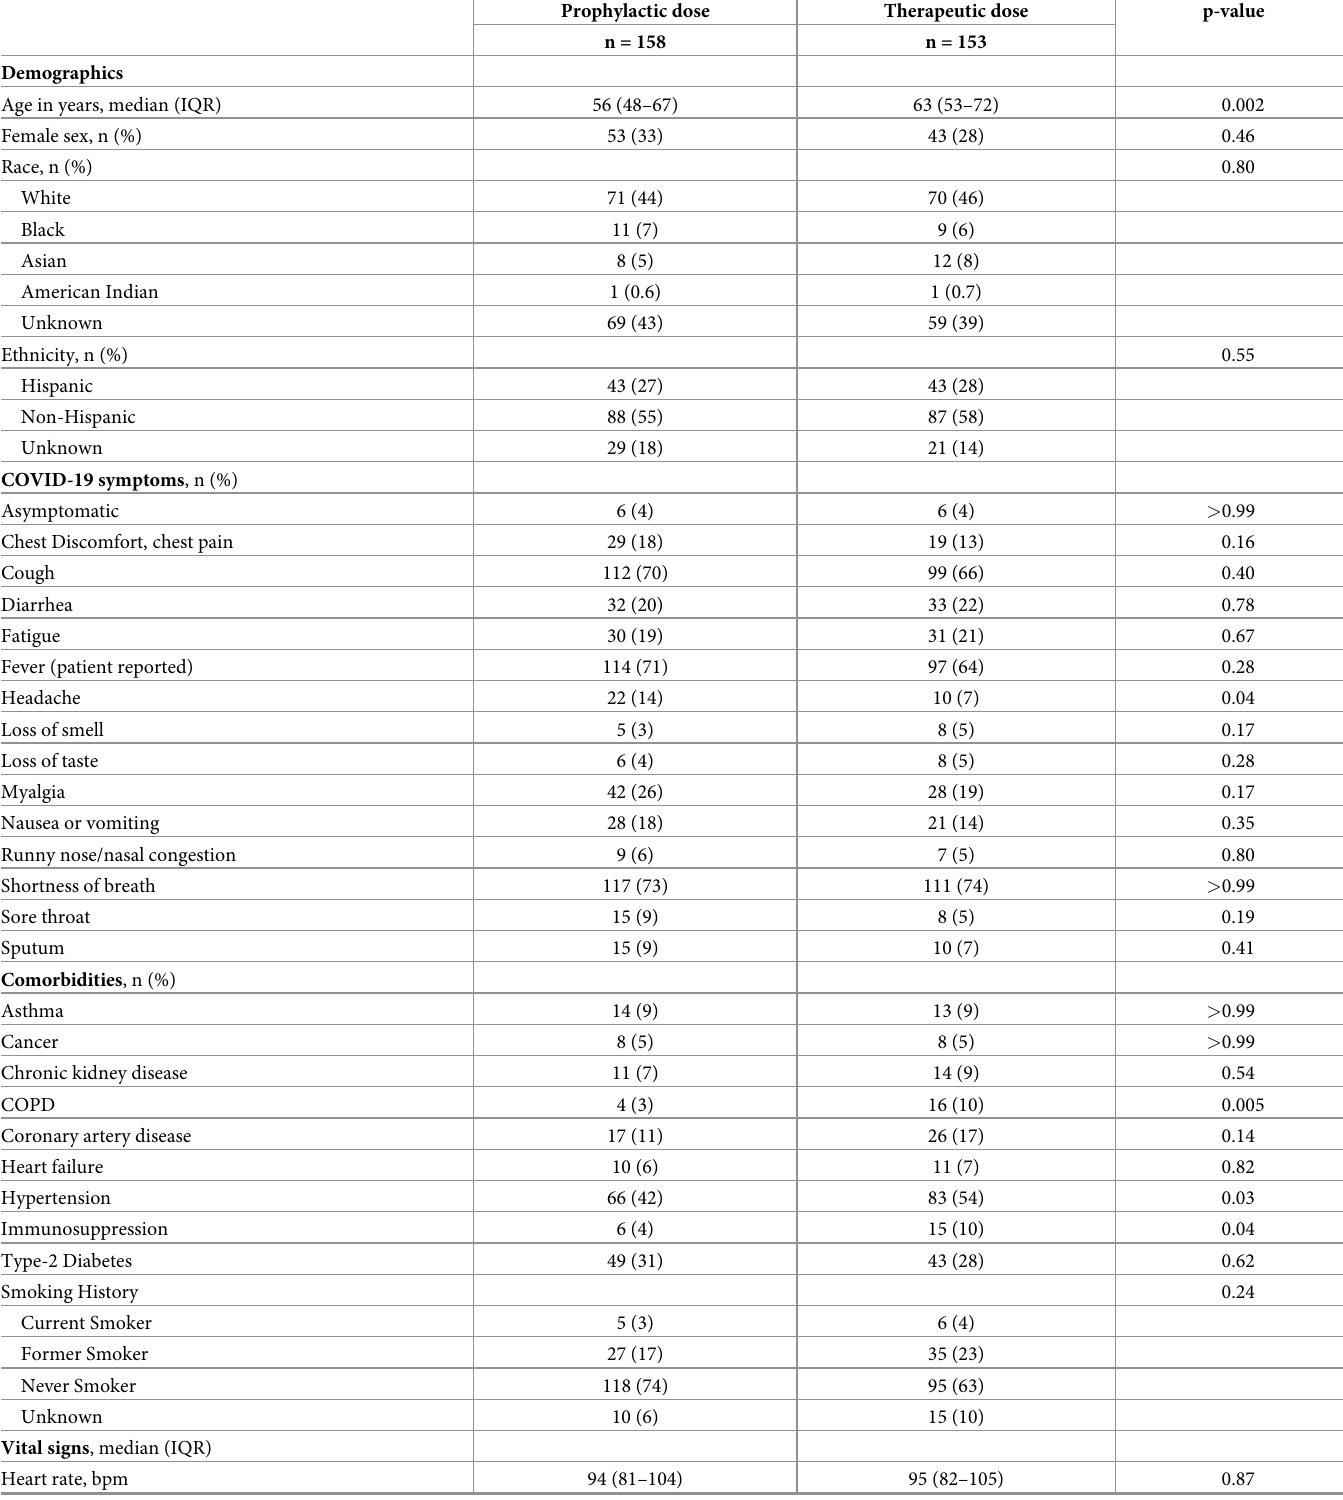
Table 1. Demographics, clinical variables and escalated care of critically ill COVID-19 patients who received prophylactic or therapeutic dose